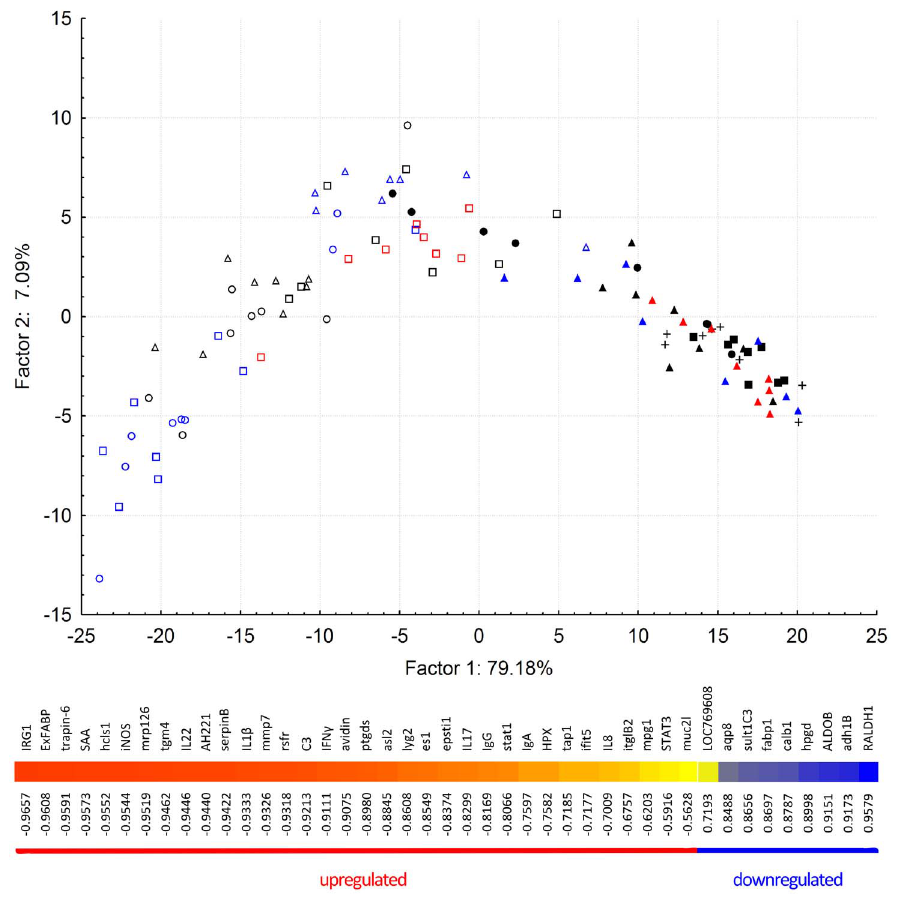
Figure 3. PCA plot of the chickens clustered according to their gene expression in the cecum and heat map correlation coefficients between factor 1 and individual gene expression. Open black circles, S . Enteritidis 147; Open blue circles, S. Enteritidis G1481; open black squares, S . Typhimurium LT2; open blue squares, S . Typhimurium 2002; open red squares, S . Typhimurium 2454; open black triangles, S . Infantis 1516; open blue triangles, S . Infantis 514; closed black circles, S . Enteritidis 147 rfaL mutant; closed black squares, S . Typhimurium LT2 rfaL mutant; closed black triangles, S . Infantis 1516 rfaL (I) mutant; closed blue triangles, S . Infantis 1516 rfaL (II) mutant; closed red triangles, S . Infantis 1516 rfaL (III) mutant. symbol ‘‘plus’’, non-infected chickens. PCA also showed that a single factor explained nearly 80% of the variation in the chicken response. This factor was the scope of inflammation itself as high and significant correlations were observed between the expression of individual genes and the positioning of corresponding chickens along X axis. Genes are arranged from the most positively correlated to the most negatively correlated ones.